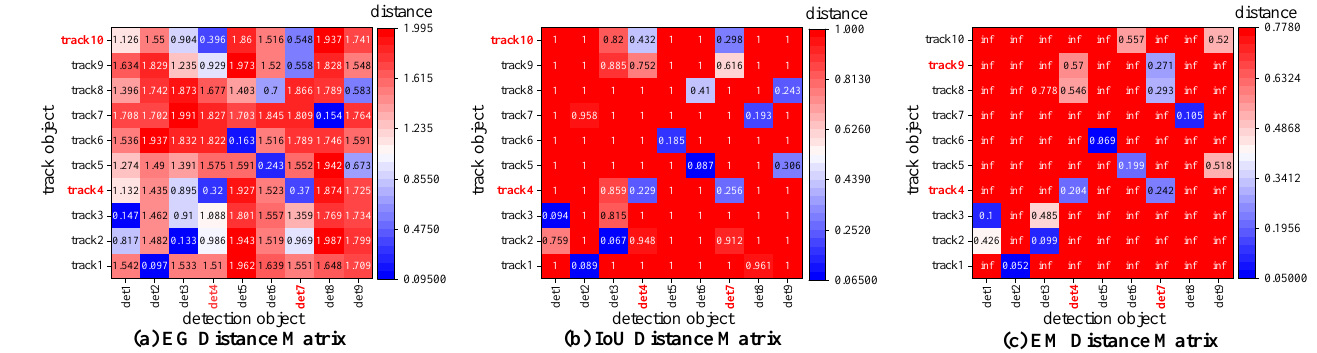
Figure 1. Example of heatmaps for different association matrices in frame 560 of MOT17 sequence 11. ( a ) shows our EG matrix, which combines the embedding cosine distance and the GioU distance. ( b ) shows the IoU distance matrix, i.e., the detection-based methods. ( c ) shows the EM matrix, which usually combines the motion distance and the embedding cosine distance, i.e., the JDE-based methods. In these heatmaps, the red cells indicates that the similarity distance between detection targets and tracking targets is farther, and the blue cells show that the similarity distance is